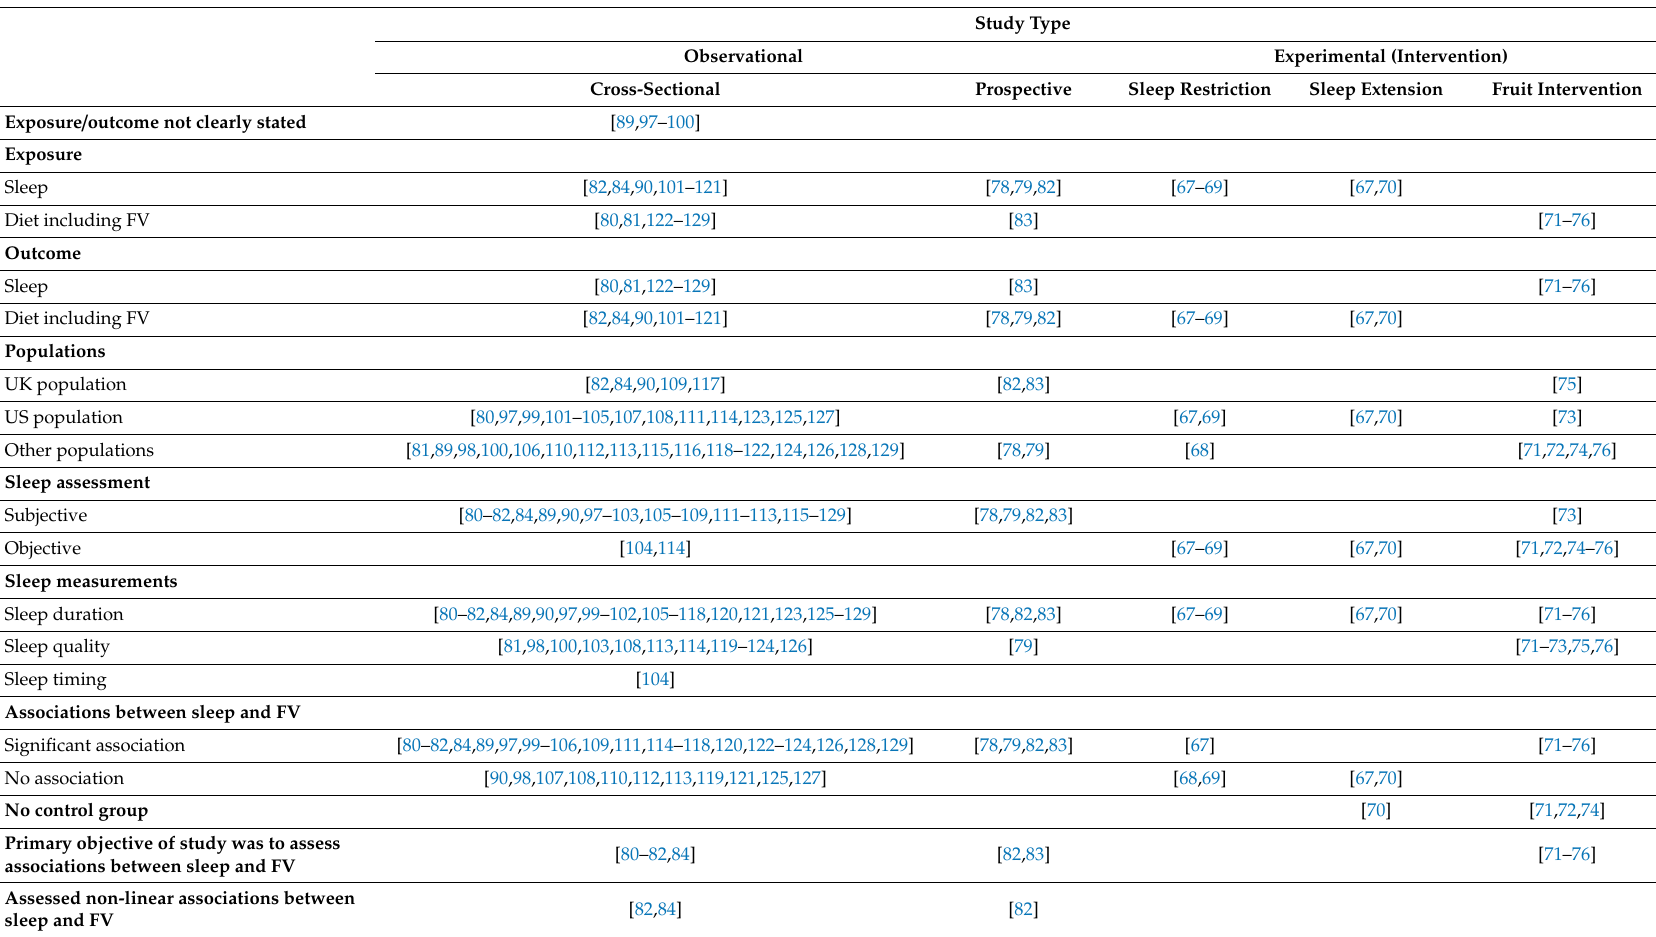
Table 1. Summary of human studies [references] assessing the association between sleep and FV consumption in adults. Study Type Observational Experimental (Intervention) Cross-Sectional Sleep Restriction Sleep Extension Fruit